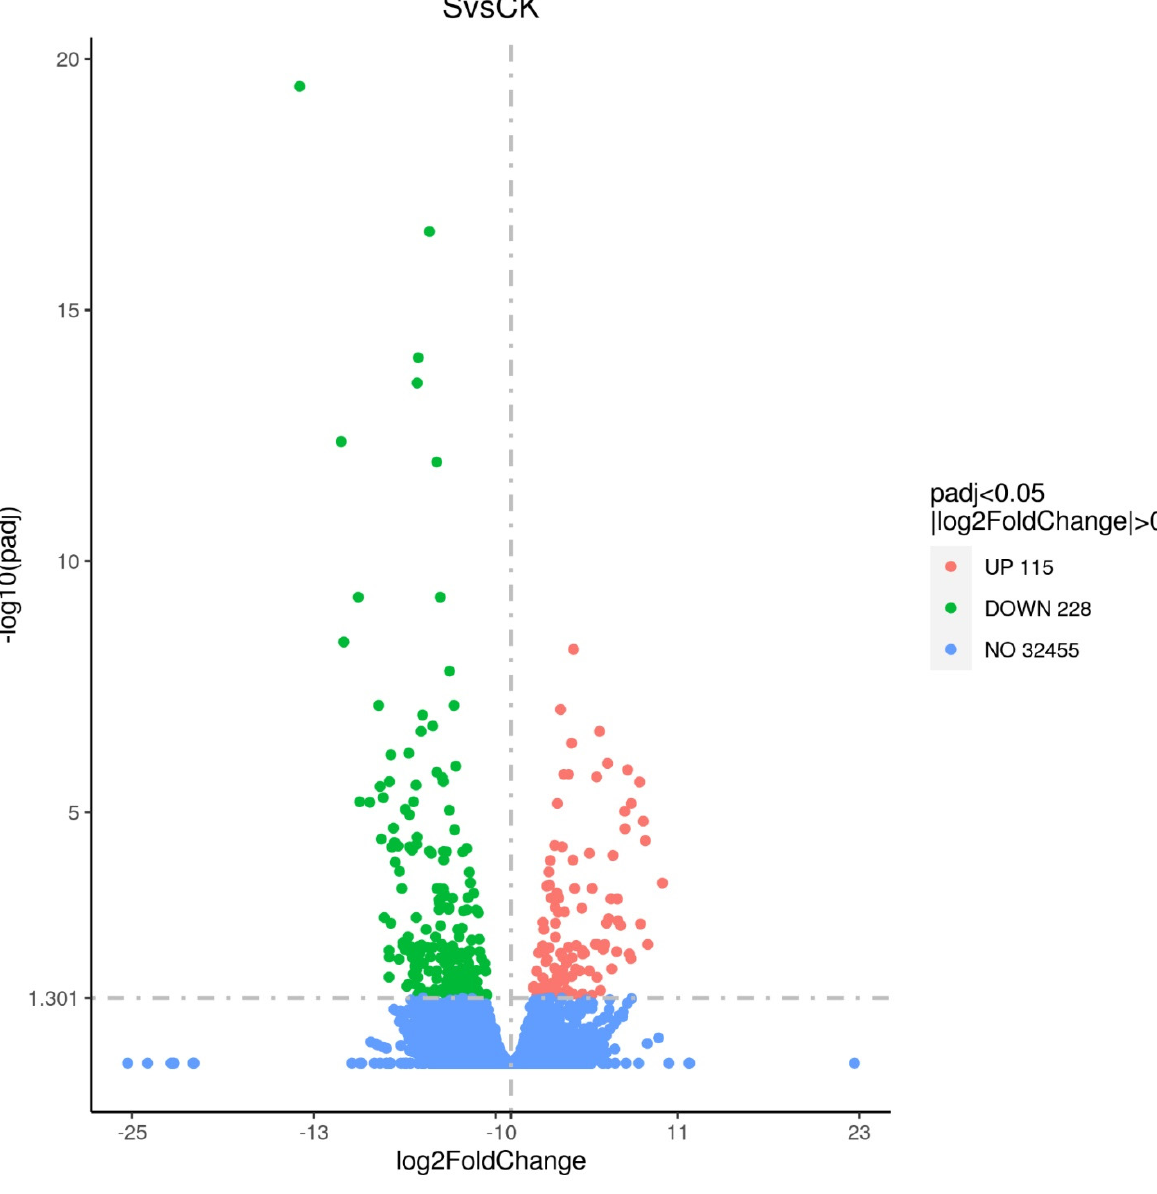
Figure 1. The difference in gene expression between control and treatment groups. Blue dots represent the total number of genes, red dots represent up − regulated genes, and green dots represent down − regulated genes. S − treatment, CK − control .